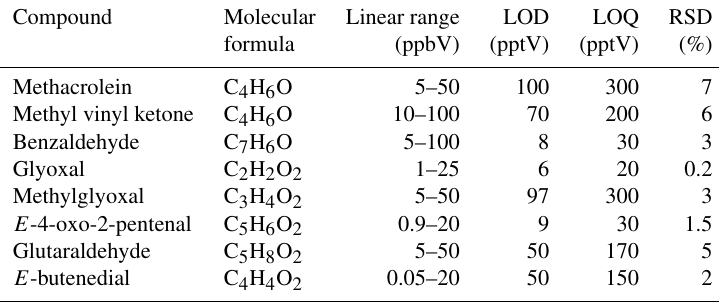
Table 3. Analytical performances for the determination of carbonyl and α -dicarbonyl compounds.